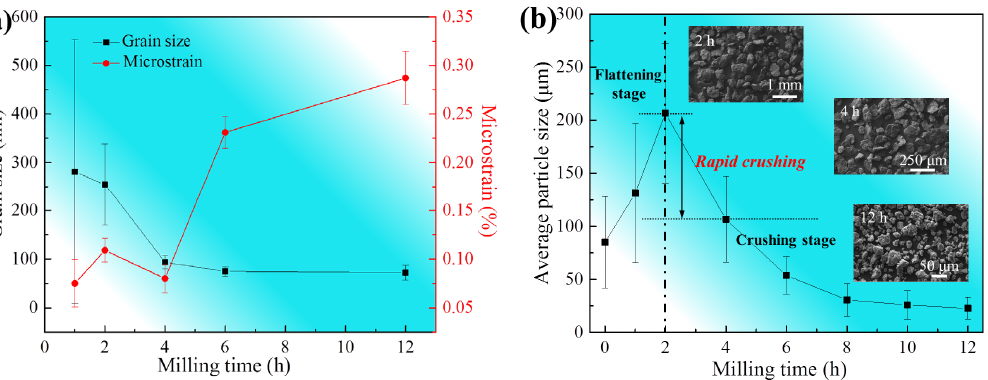
Figure 3. Evolution of grain size, the microstrain ( a ) and particle size ( b ) for the milled Ti/Mg-9Al-Zn-0.3Mn composite.